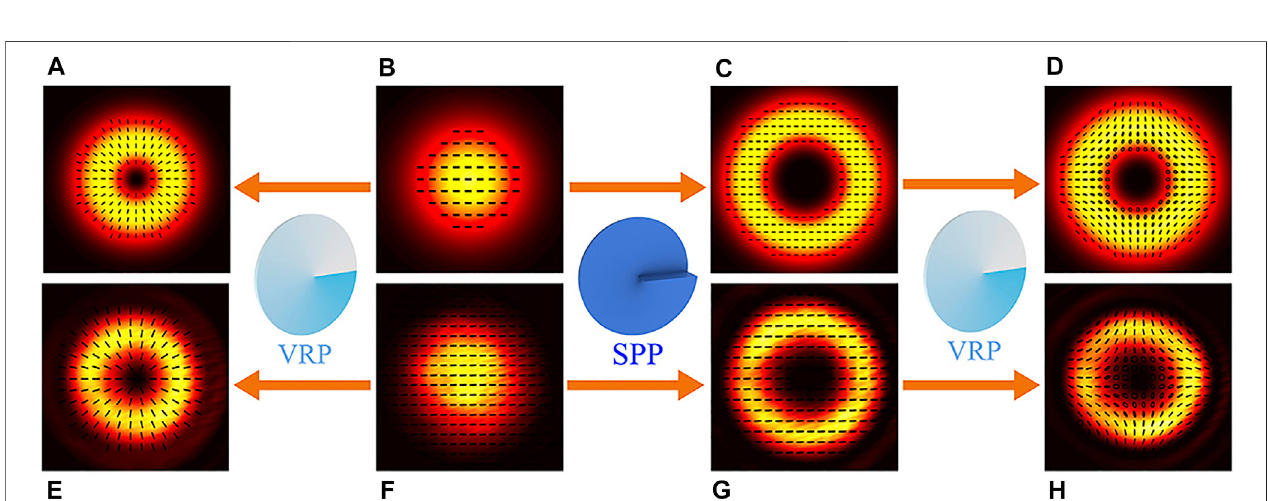
FIGURE 2 | Schematic of generating the experimental light beams. SPP: spiral phase plate; VRP: retardation wave plate. (B, F) the theoretical and experimental Gaussianbeam,respectively. (A,C,D) thegenerationofOAMbeams,symmetricandasymmetricVBsintheory. (E,G,H) thegenerationofOAMbeams,symmetricand asymmetric vector beams in experiment. Linearly polarized Gaussian beam (F) directly passes through a VRP (or SPP) to generate a symmetric vector beam (E) [or a linearly polarized OAM beam (G) ]. For the generation of an asymmetric vector beam (H) , the linearly polarized OAM beam (G) continues to run through a VRP.